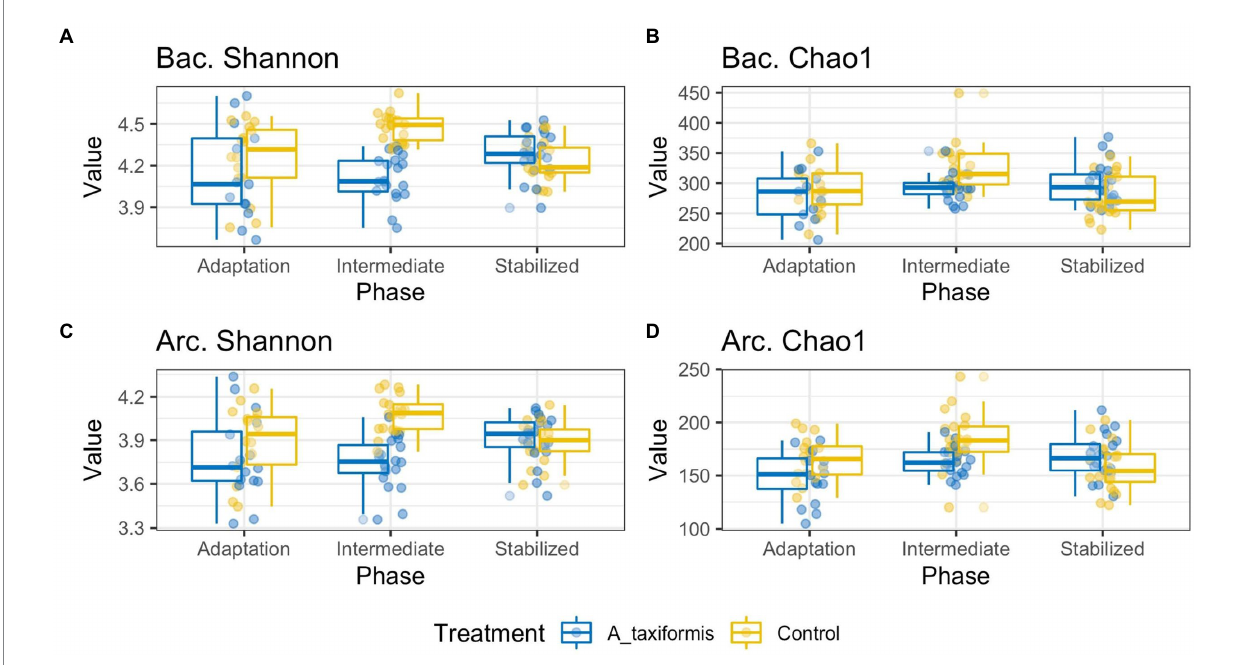
FIGURE 3 Alpha diversity boxplots of bacterial (Bac) and archaeal (Arc) sequencing data. Samples are grouped according to phase. All data was rarefied to an even depth prior to metric calculation. Panels (A–D) depict Shannon Evenness and Chao1 Richness metrics for A. taxiformis and control